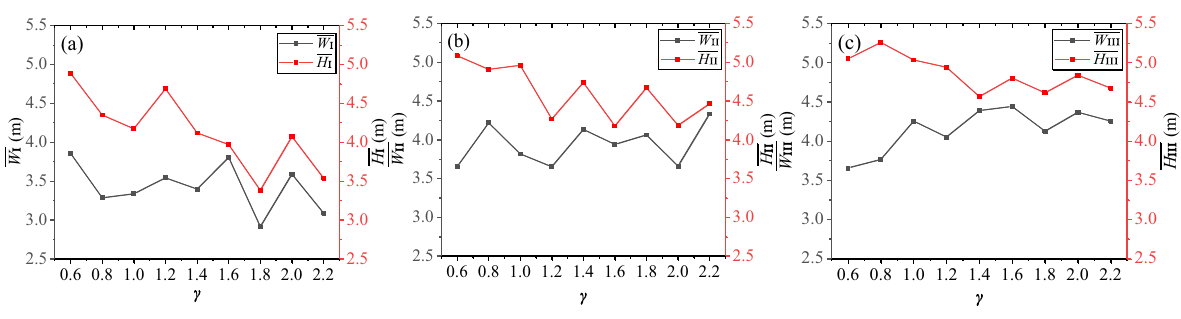
Fig. 13 Average widths and heights of the drawing bodies: a S